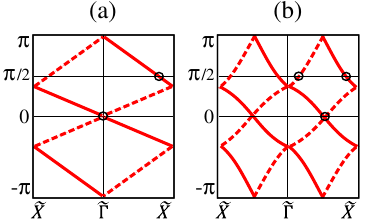
FIG. 7. Illustrating the single-energy criterion to determine the − 1 in (a) and − 2 in parity of the mirror-Chern number ( C ): C e e ¼ (b). Red solid (dashed) lines correspond to a Wilson band with i ( − i mirror eigenvalue λ z ¼ þ